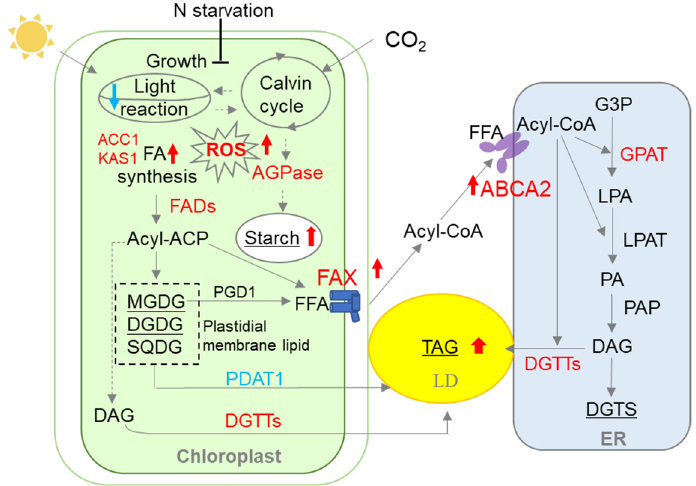
Figure 6. Hypothetical model explaining adjustment of lipid and starch metabolism with increased expressions of FAXs and ABCA2 in Chlamydomonas under N starvation conditions. ABCA2, ATP-binding cassette transporter subfamily A2; FAX, fatty acids exporters; ACC1, acetyl-CoA carboxylase; DGTTs, type II diacylglycerol acyltransferases; DGDG, digalactosyldiacylglycerol; G3P, glycerol3-phosphate; ACP, acyl carrier protein; DAG, diacylglycerol; LPAT, lysophosphatidic acid acyltransferase; MGDG, monogalactosyldiacylglycerol; PA, phosphatidicacid; LPA, lysophosphatidicacid; PAP, phosphatidic acid phosphatase; PGD1, plastid galactoglycerolipid degradation 1; DGTS, diacylglyceryltrimethylhomoserine; LD, Lipid droplet; KAS1, 3-ketoacyl-CoA-synthase; SQDG, sulfoquinovosyldiacylglycerol; PDAT1, phospholipid:diacylglycerolacyltransferase 1; ER, endoplasmic reticulum; FFA, free fatty acids; TAG, triacylglycerol. The increased metabolites are underlined. The upregulated and downregulated key genes involved in lipid and starch biosynthesis are colored in red and blue, respectively.